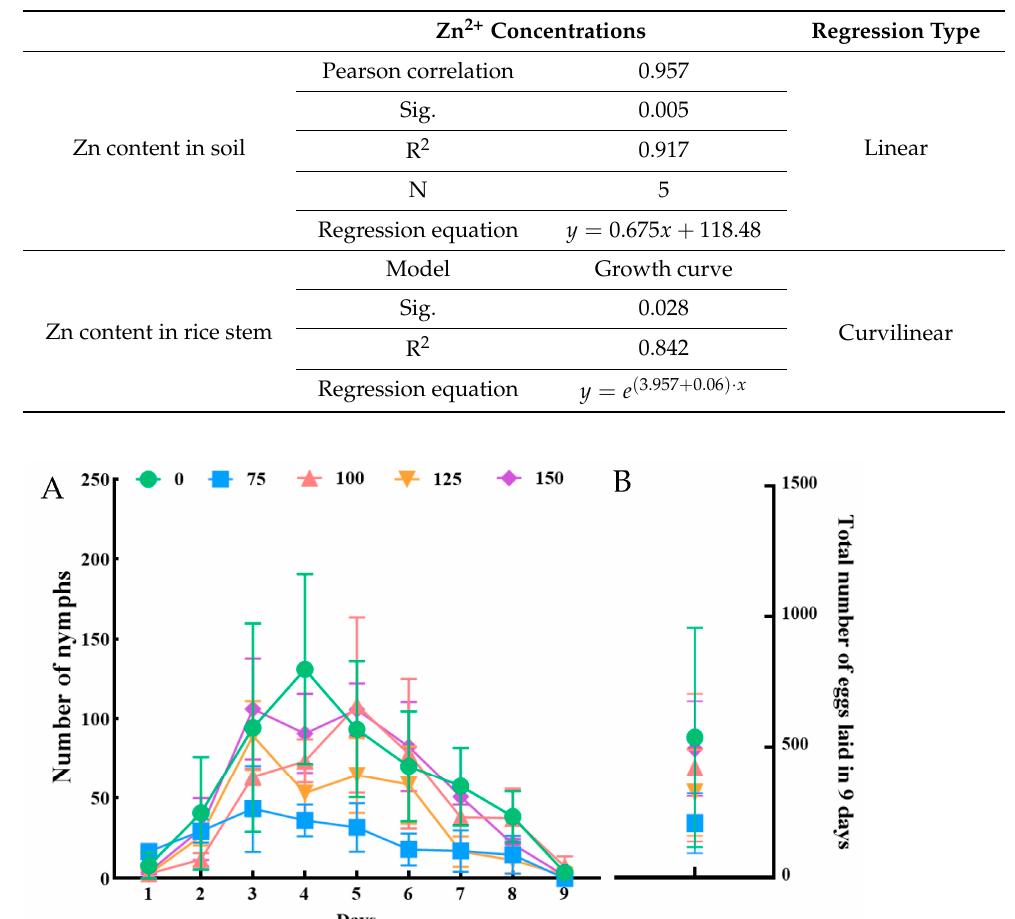
Figure 2. Zn content accumulated in soil ( A ) and rice plants ( B ) after irrigating with different concentrations of Zn 2+ solution. The data are represented as mean ± SE ( n = 3). Tukey’s test was used to detect the significant differences among different groups, and different letters indicate significant differences. Table 2. Regression analysis of Zn accumulation in soil and rice stem.